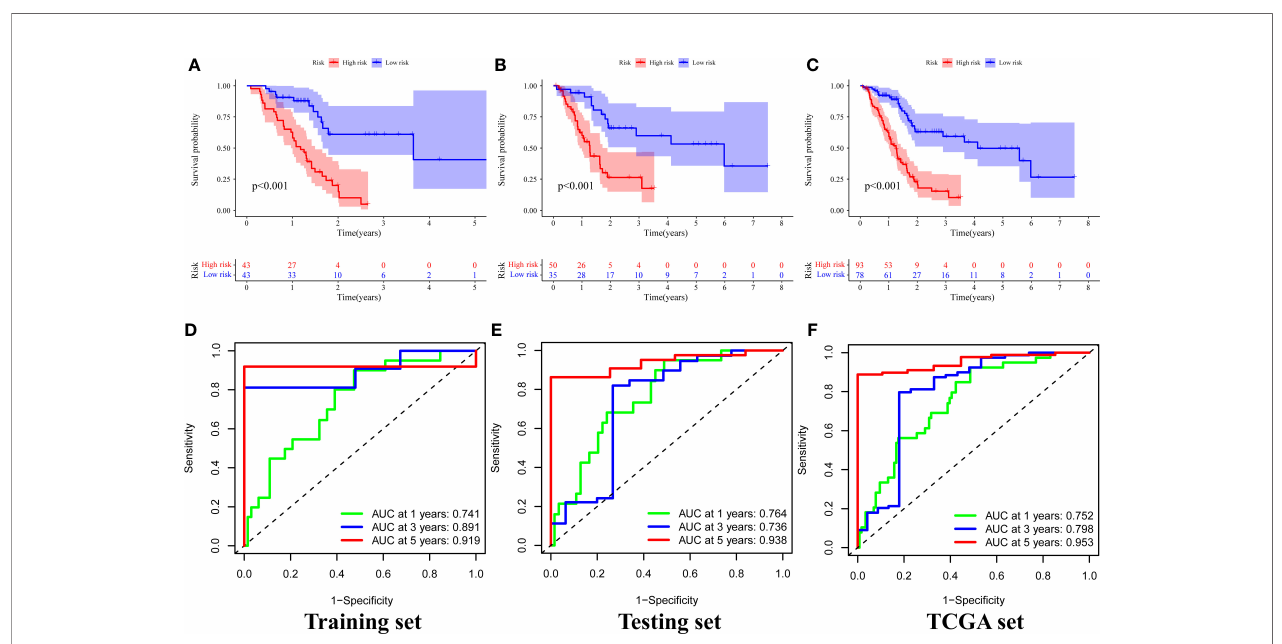
FIGURE 4 | Survival analysis and results of signature prediction accuracy assessment in the training, testing, and TCGA sets. Comparison of survival rates between high-risk and low-risk groups in the training (A) , testing (B) , and TCGA sets (C) . ROC curve for 1-, 3-, and 5-year survival prediction of the signature in the training (D) , testing (E) , and TCGA (F)